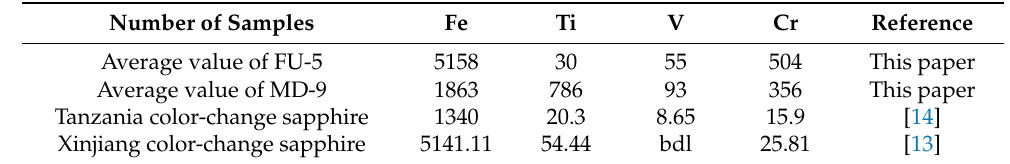
Table 2. Trace element compositions of color-change sapphire from Fuping and Xinjiang in China, Mogok in Myanmar and Tanzania